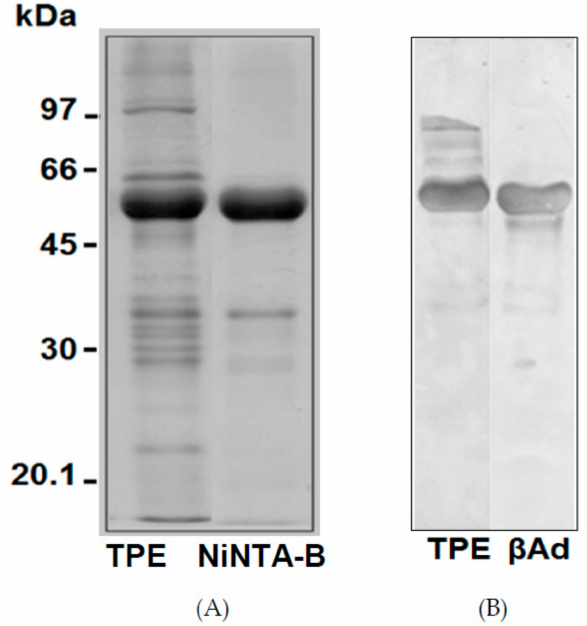
Figure 6. SDS-PAGE profile under reducing conditions of TPE and Ni-NTA-bound material ( A ), Western blot analysis with the concanavalin A ( B ). TPE represents the total protein extract from adzuki bean flour, β Ad represents the adzuki bean β -vignin protein.